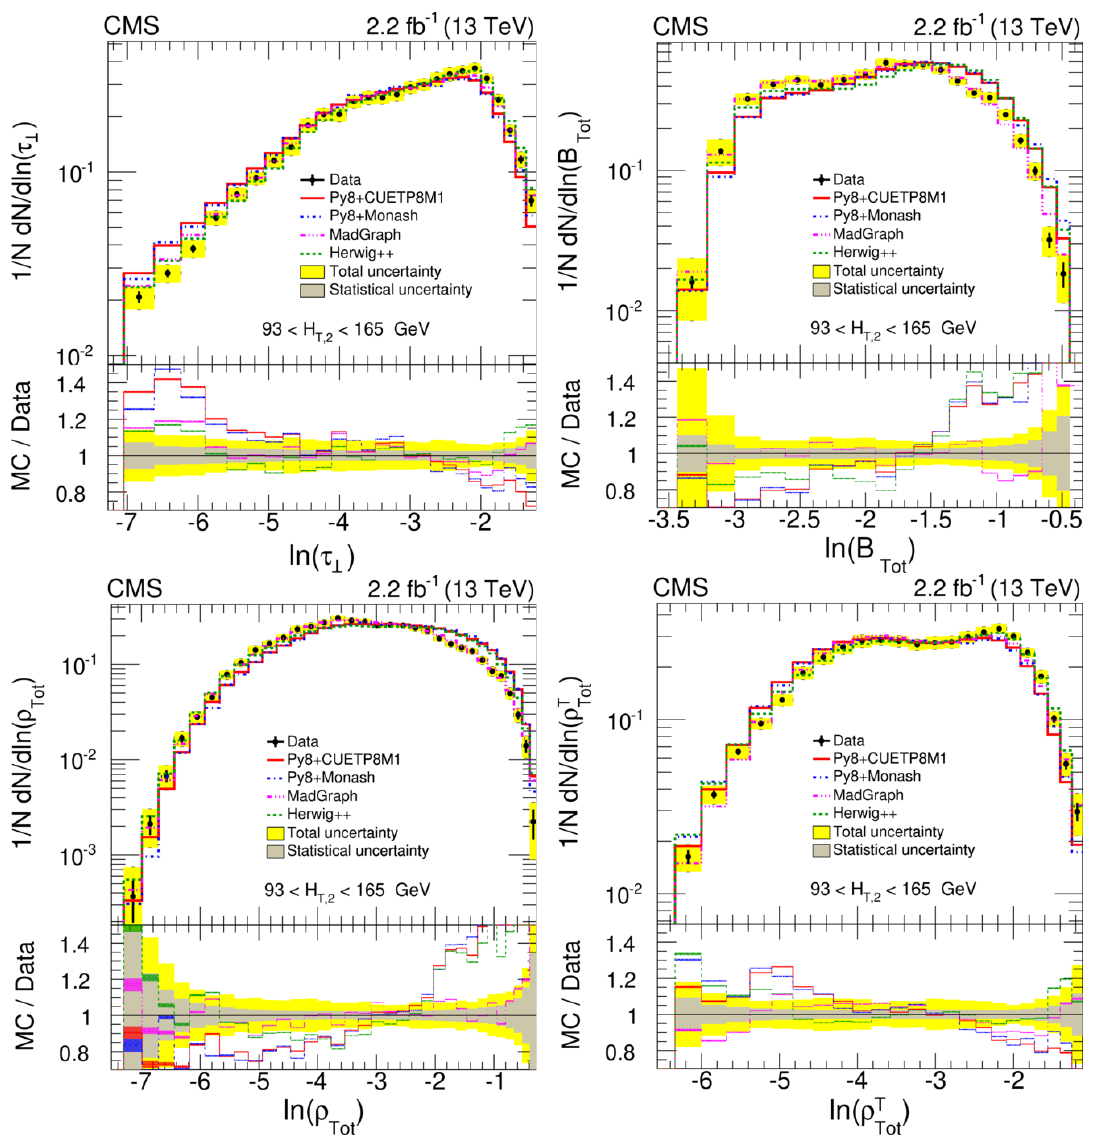
Figure 4 . Normalized di(cid:11)erential distributions of unfolded data compared with theoretical (MC) predictions of pythia 8 CUETP8M1 (red line), pythia 8 Monash (blue dash-dotted line), Mad- Graph 5 a mc@nlo (pink dash-dot-dotted line) and herwig++ (brown dash-dot-dotted line) as a function of ESV: complement of transverse thrust ( (cid:28) ? ) (upper left), total jet broadening ( B Tot ) (upper right), total jet mass ( (cid:26) Tot ) (lower left) and total transverse jet mass ( (cid:26) T for 93 < H T ; 2 < 165 GeV. In each ratio plot, the inner gray band represents statistical uncertainty and the yellow band represents the total uncertainty (systematic and statistical components added in quadrature) on data and the MC predictions include only statistical uncertainty.